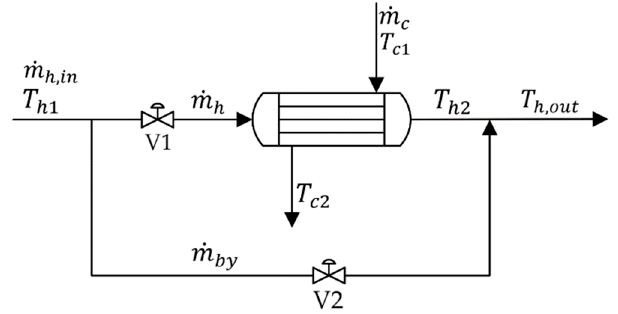
Table 1. Relation between controller output (CO) and valve opening in the complementary split- range temperature control arrangement. Notice that the two valves have opposite fail positions.